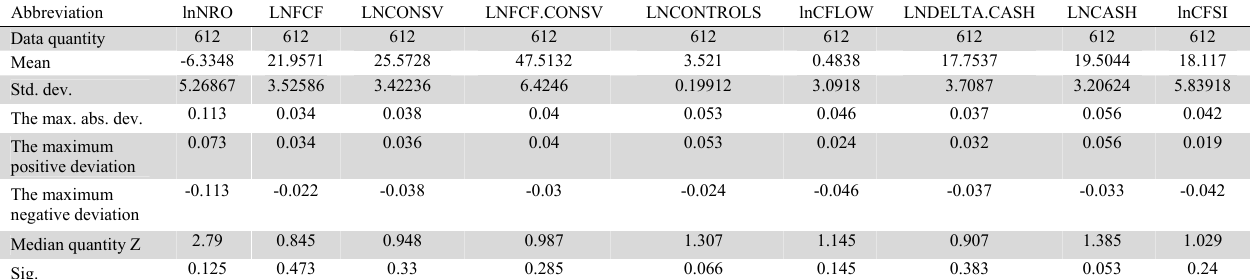
The summary of Kolmogorov-Smirnove test for the converted